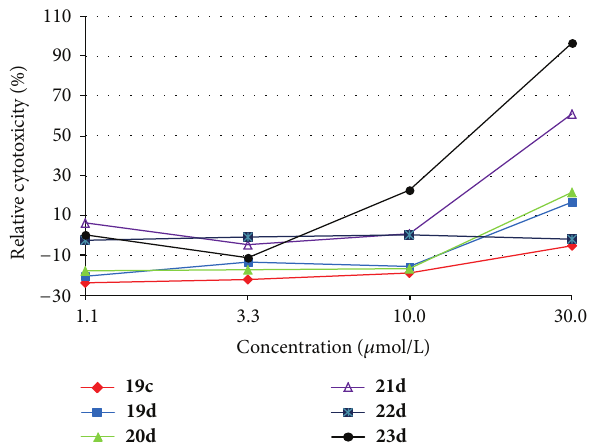
Figure 3: Cytotoxicity of tested compounds 19c , 19d , 20d , 21d , 22d , and 23d against human THP-1 cells after 24h